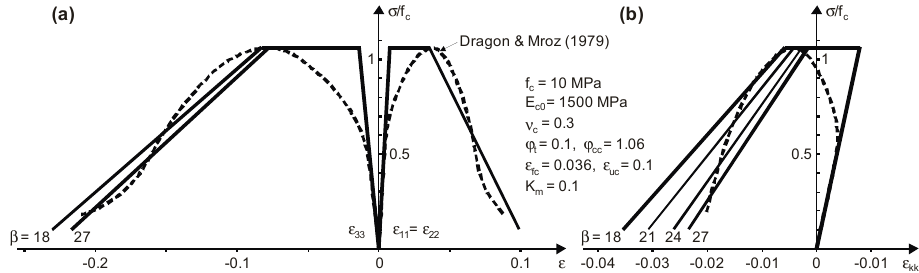
Figure 7. Comparison of the proposed model with Dragon’s and Mróz’s [27] solution for biaxial compression: ( a ) graph of stress vs. longitudinal and lateral strains; ( b ) graph of stress vs. volumetric strains.